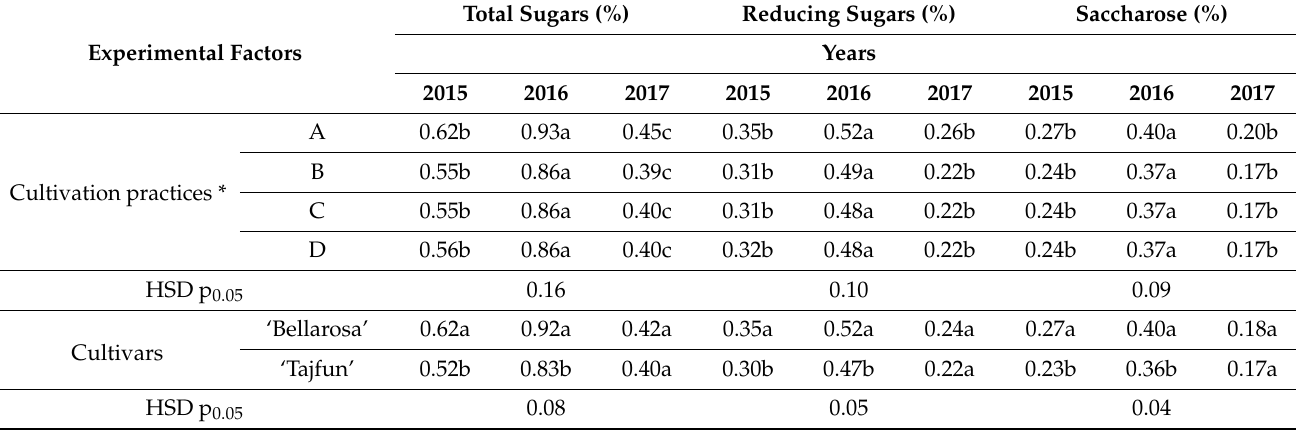
Table 11. Influence of cultivation practices, cultivars, and years on total sugars, reducing sugars, and saccharose.